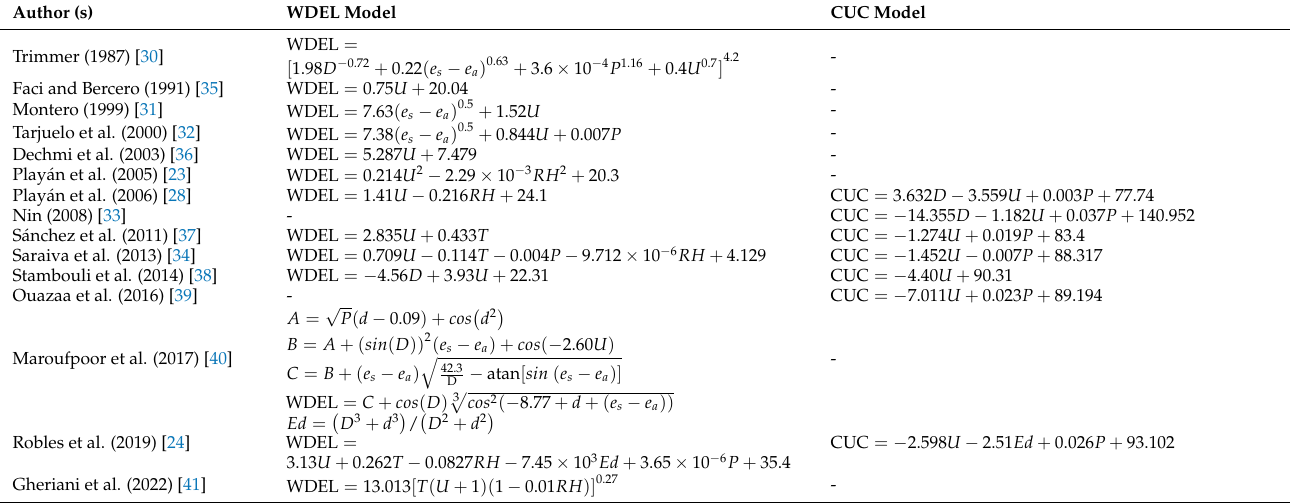
Table 2. WDEL and CUC models reported by different authors selected for